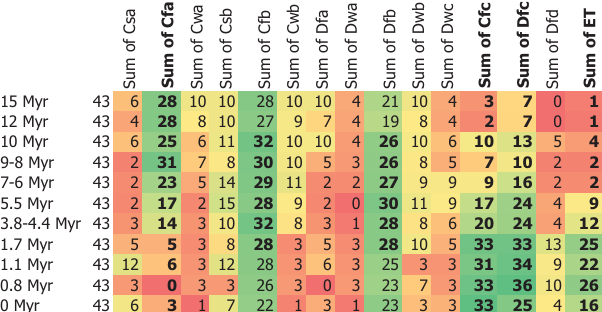
Fig. 4. The heat map shows the sum of fossil taxa with modern analogues occurring in certain Köppen climate types. Number of taxa scoring for particular climate types was scaled to 43 for all rock